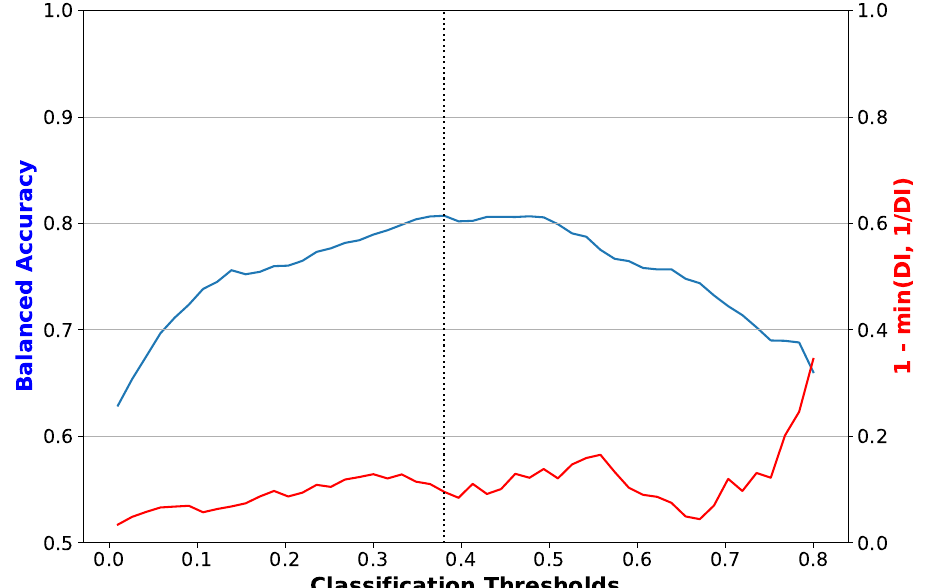
Figure 6. Balanced accuracy and disparate impact error versus classification threshold for a logistic regression classifier with prejudice remover. The dotted vertical line is the threshold that maximizes balanced accuracy. The plot shown corresponds to one of the folds of cross-validation. Disparate impact error, equal to 1- min (DI, 1/DI), where DI is the disparate impact, and the difference between disparate impact and its ideal value of 1.